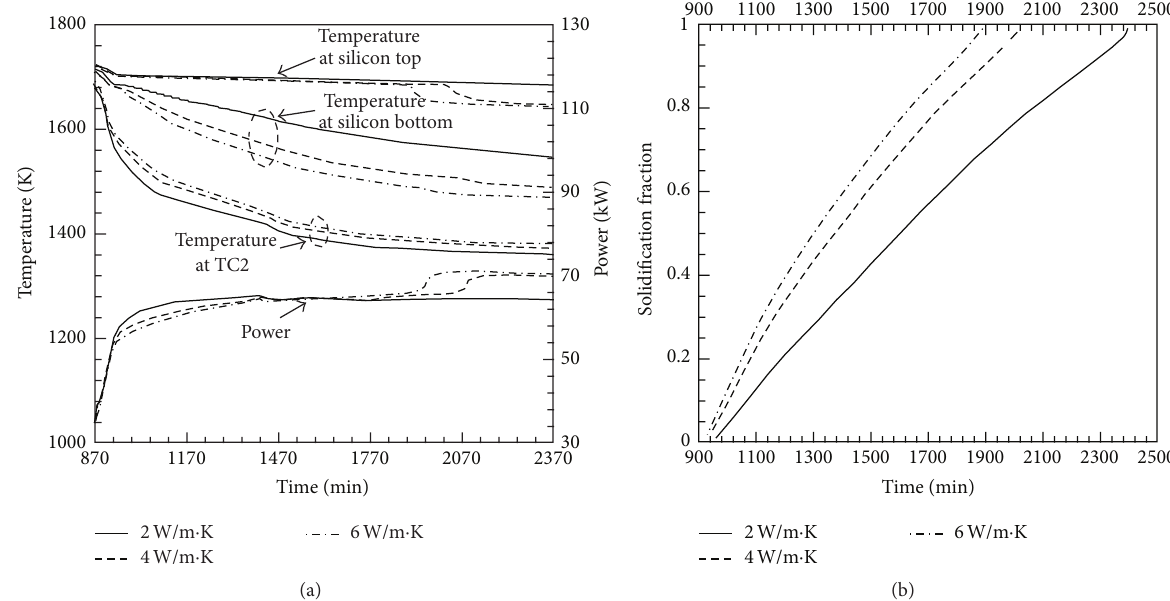
Figure 4: Evolution of process parameters during the growing stage for DS processes with different crucible thermal conductivities: (a) evolutions of temperature and power; (b) evolution of solidification